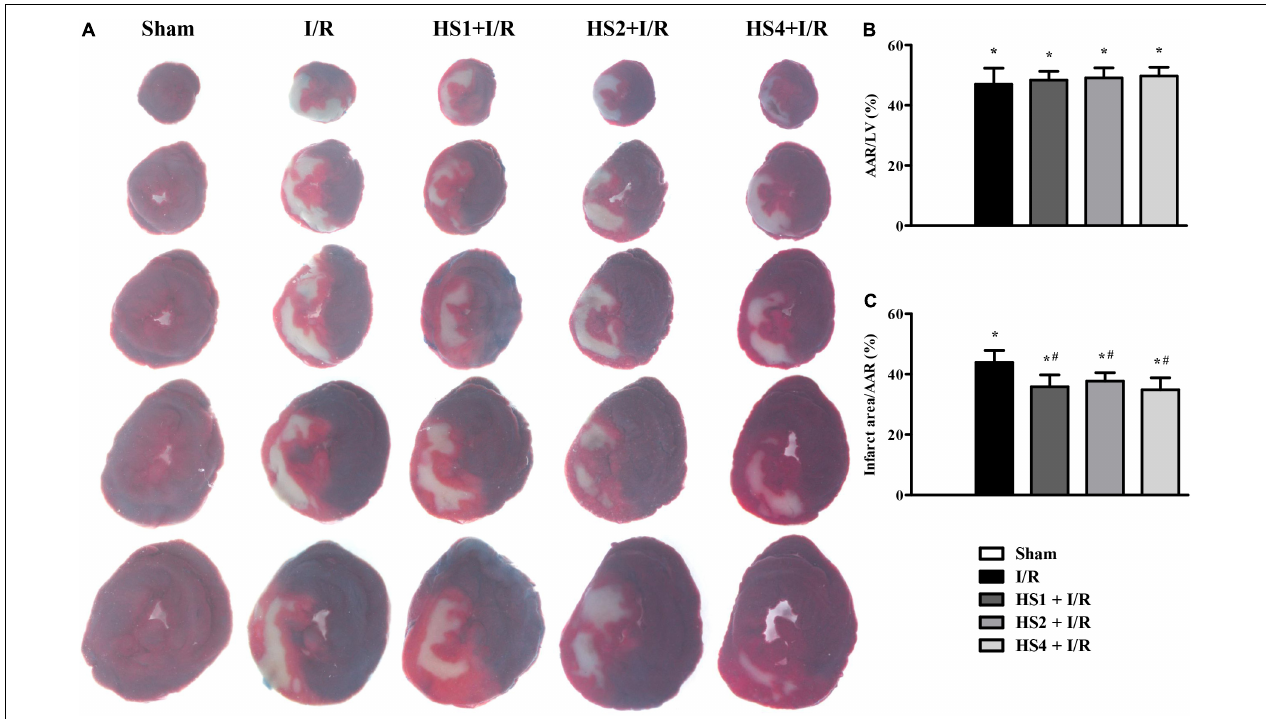
FIGURE 2 | Effect of Herba Siegesbeckiae (HS) on Ischemia/Reperfusion (I/R)-induced myocardial infarct size in rats. (A) Representative myocardial tissue slices stained by Evans blue-TTC in Sham, I/R, HS1 + I/R, HS2 + I/R, and HS4 + I/R groups. (B) Quantitative analysis of AAR/LV in various groups ( n = 6). (C) Quantitative analysis of infarct area/AAR in various groups ( n = 6). * P < 0.05 vs. Sham group, # P < 0.05 vs. I/R